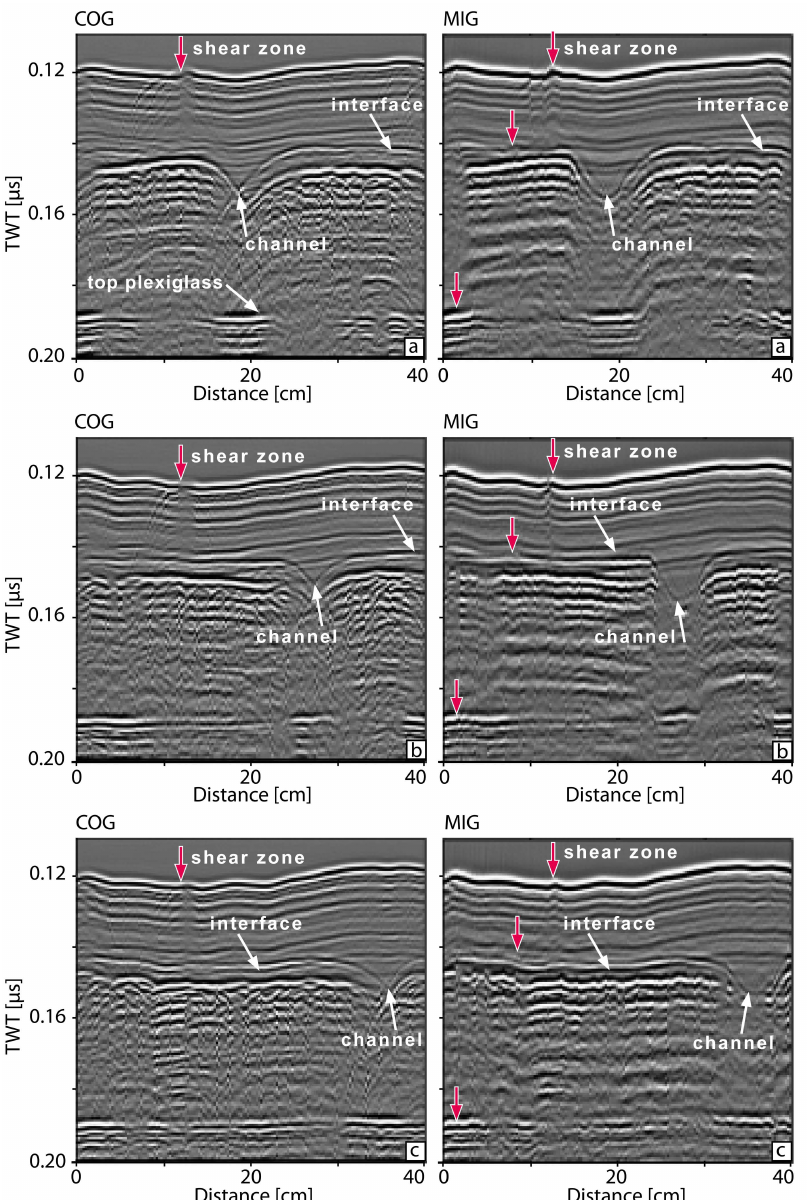
Fig. 9. Constant-offset gathers (COG; left) and time-migrated sections (MIG, right) image the channel model at three different profile positions across the analogue model (cf. Fig. 7, profiles a–c; vertical exaggeration is ca. 6). The distance between shear zones and channel structures varies, but in all sections these can be clearly imaged separately. The subtle traces of the shear zone are indicated by red